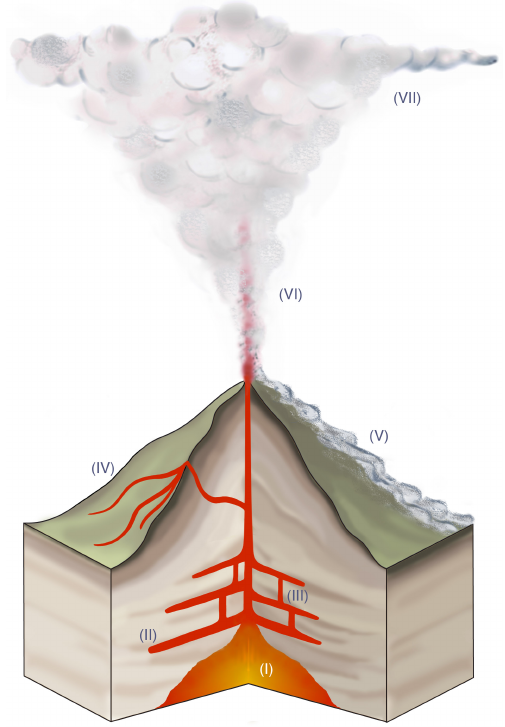
Figure 1. Schematic illustration of the magmatic and volcanic phe- nomena that have been modelled in the laboratory and in numerical simulations. In this review we focus on (I) magma chambers (see Sect. 5), magma sheet intrusions such as (II) sills and (III) dykes (see Sect. 6), lava lakes (Sect. 7), lava domes (see Sect. 8), (IV) lava flows (Sect. 9), (V) pyroclastic density currents and lahars (see Sect. 10), (VI) volcanic plumes (see Sect. 11), and (VII) volcanic ash dispersal (see Sect.